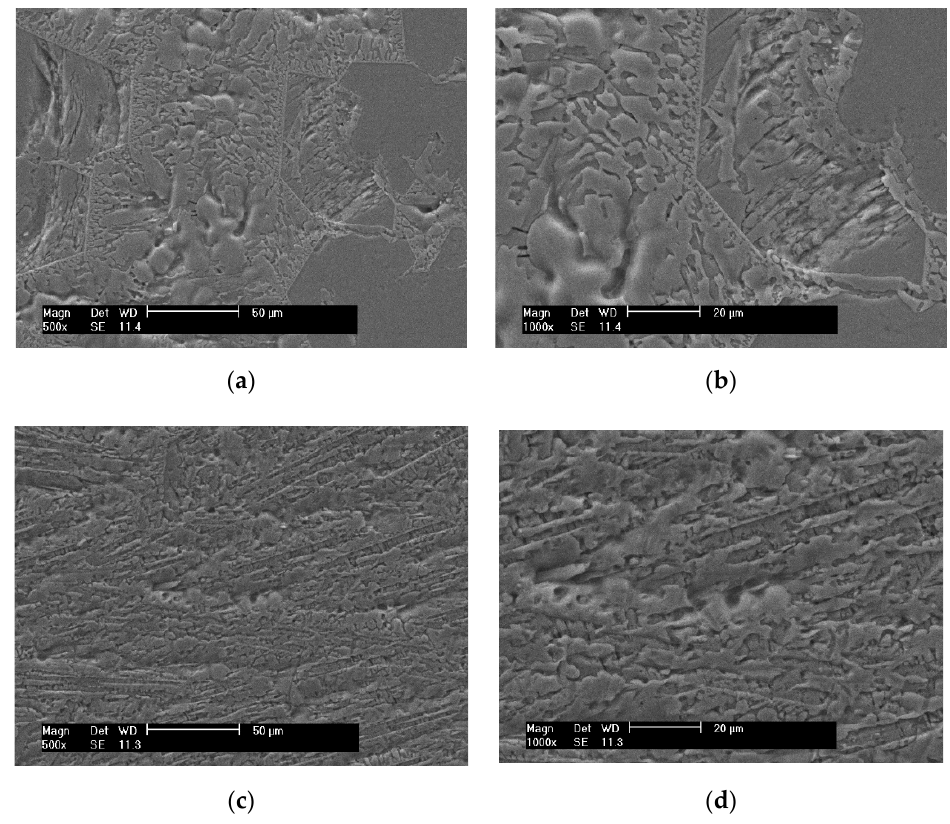
Figure 2. The SEM microstructure of Ti75Zr11Si9Fe5 (At %) and Ti66Zr11Si15Fe5Mo3 (At %): ( a ) Ti75Zr11Si9Fe5 (At %) (500×), ( b ) Ti75Zr11Si9Fe5 (At %) (1000×), ( c ) Ti66Zr11Si15Fe5Mo3 (At %) (500×) and ( d ) Ti66Zr11Si15Fe5Mo3 (At %) (1000×).